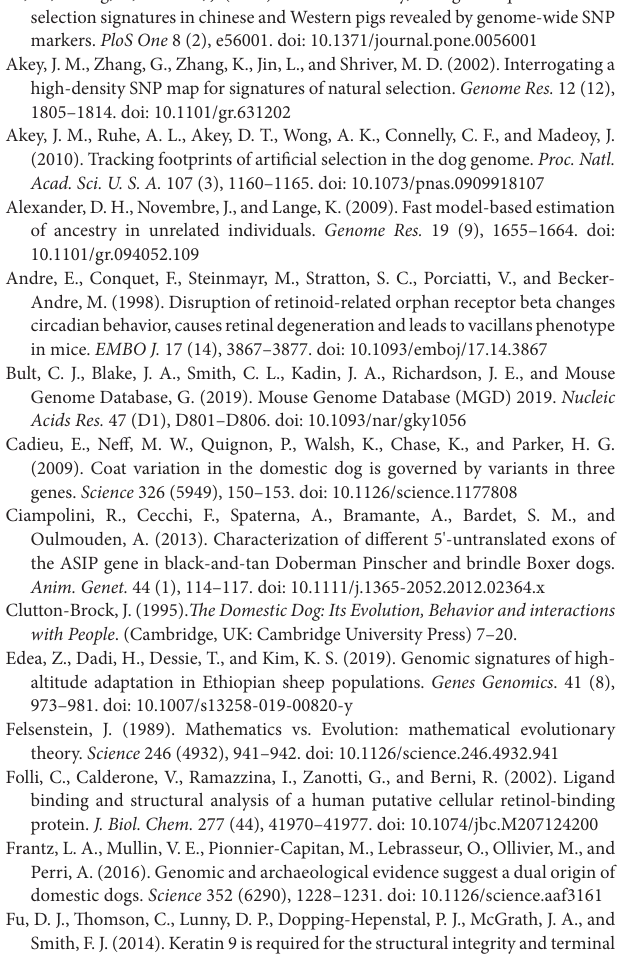
FIGURe S12 | Genome-wide scan for selection signatures in three dog populations of Qinghai-Tibet plateau dogs, Xi dogs and Mountain hounds to identify selection signals that may be related to high-altitude adaptation, running speed and hunting ability in mountain, respectively. The y-axis shows xpehh values of extended homozygosity haplotype. The analysis was performed for autosomal SNPs in 200-kb windows using Selscan software. The interesting candidate genes are also indicated in the figures. TaBle S1 | Three specific dog groups used for detecting signatures of selection. TaBle S2 | Details about gene flow between Chinese and Western dog populations from ABBA-BABA analyses. TaBle S3 | The windows showing selection signatures identified in each of Chinese indigenous dog